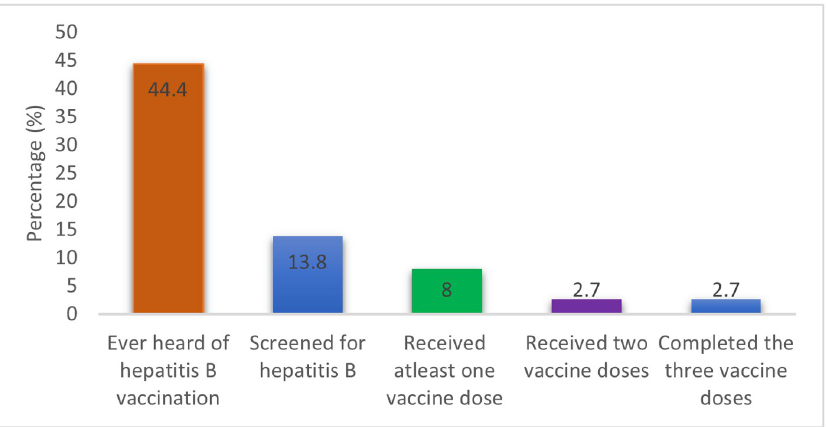
Fig 2. Hepatitis B testing and vaccination among young psychoactive substance users in Kampala’s informal settlements.